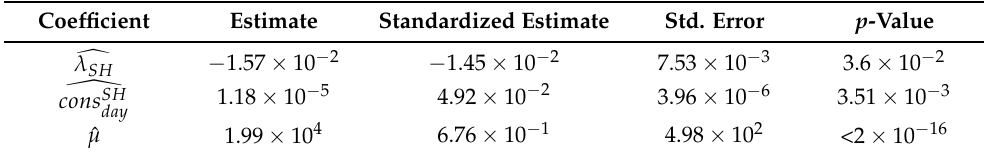
Table 10. Regression analysis coefficients result for